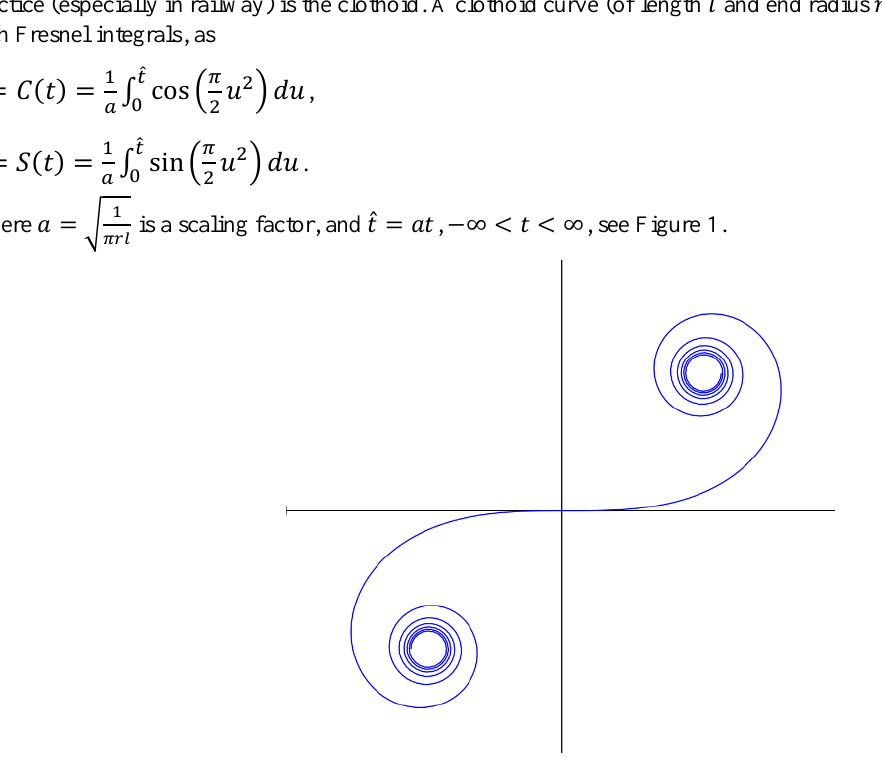
Figure 1. The clothoid spiral.